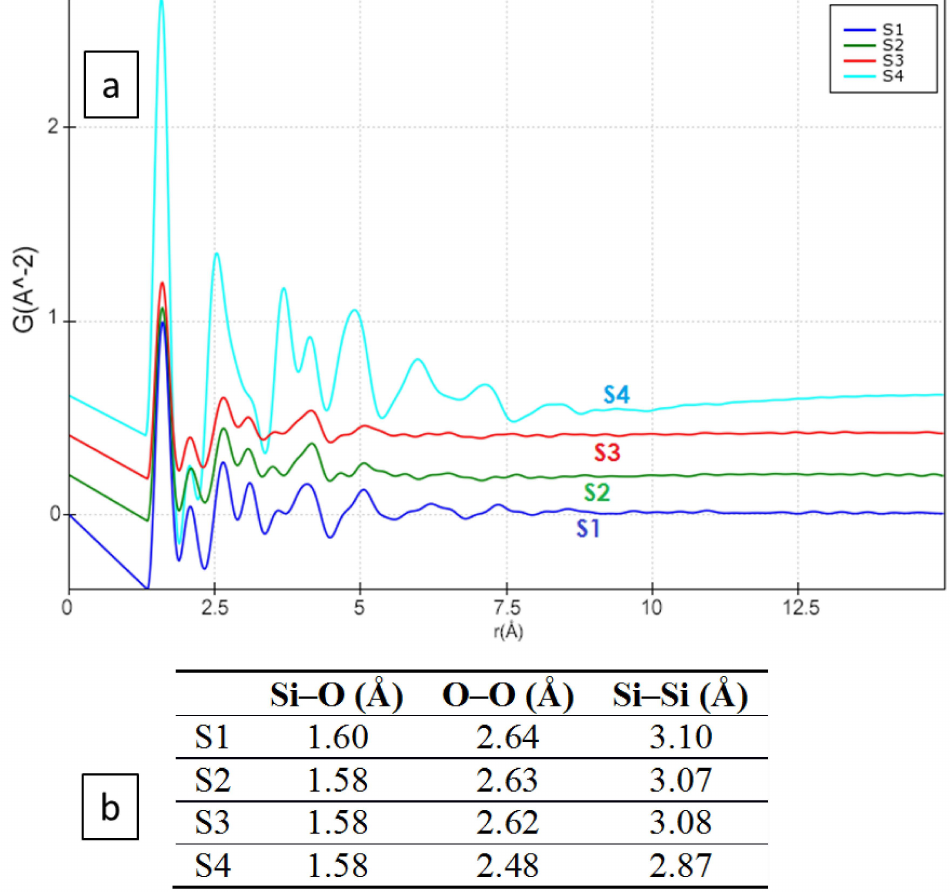
Figure 8. ( a ) The calculated electron pair distribution function (e-PDF) from S1–S4, where the x-axis represents the interatomic distances in Å and the y-axis represents the probability (in arbitrary units) of finding two atoms at distance r . ( b ) Calculated of the peak position from the e-PDF